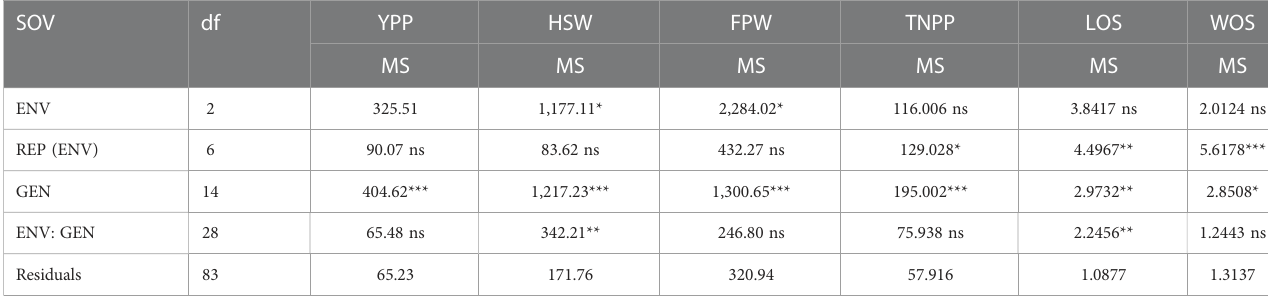
TABLE 4 Mean squares of combined analysis of variance of Bambara groundnut yield and yield components in three locations. SOV